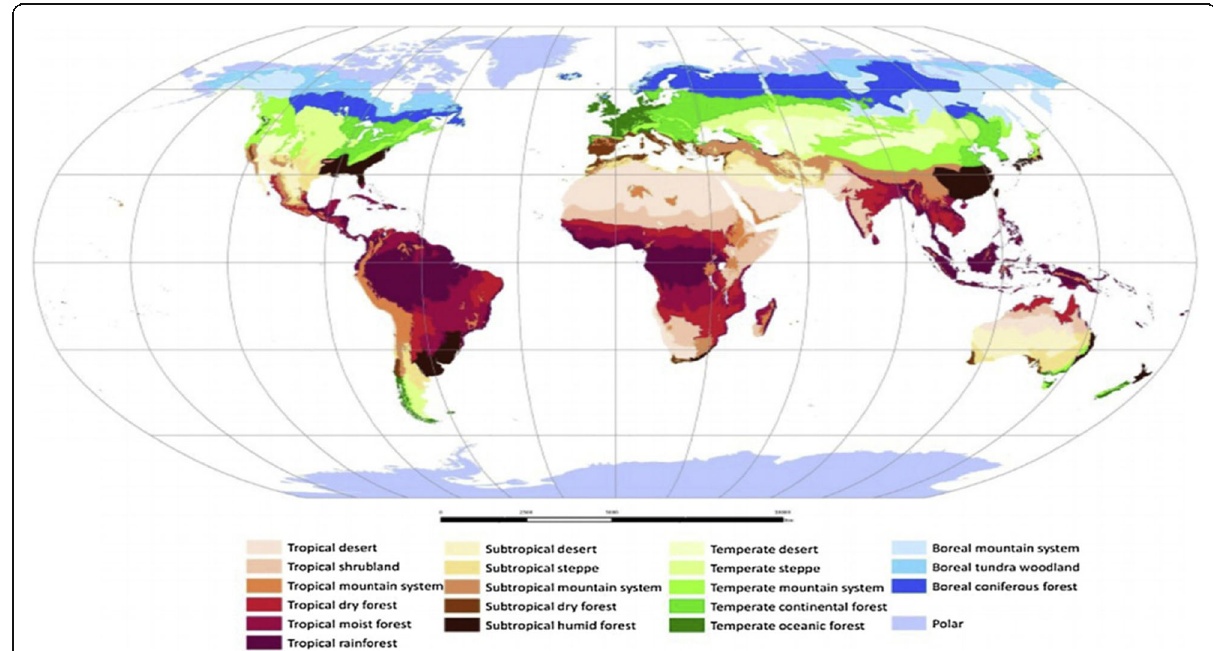
Fig. 1 World ecozones showing the distribution of dry forests (Source: FAO